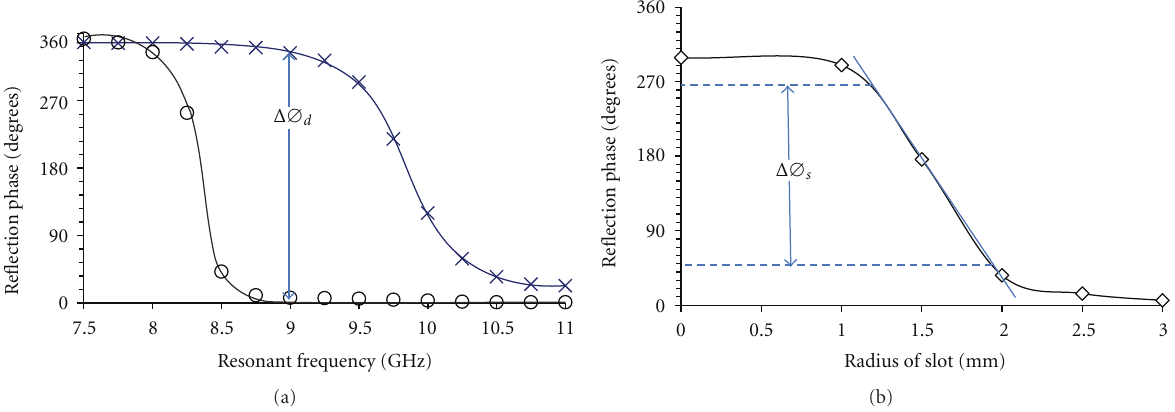
Figure 6: (a) Dynamic phase range, (b) measured static linear phase range of phase shift versus slot size curve for circular slot configurations at 9.75 GHz.